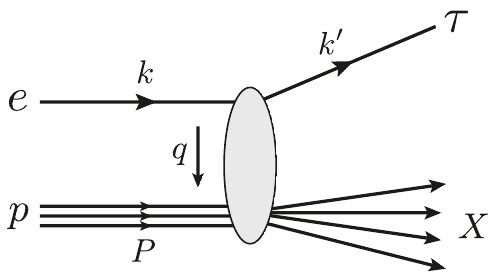
Figure 2 . The DIS process induced by CLFV SMEFT operators. The gray blob represents arbitrary CLFV interactions mediating ep → τX